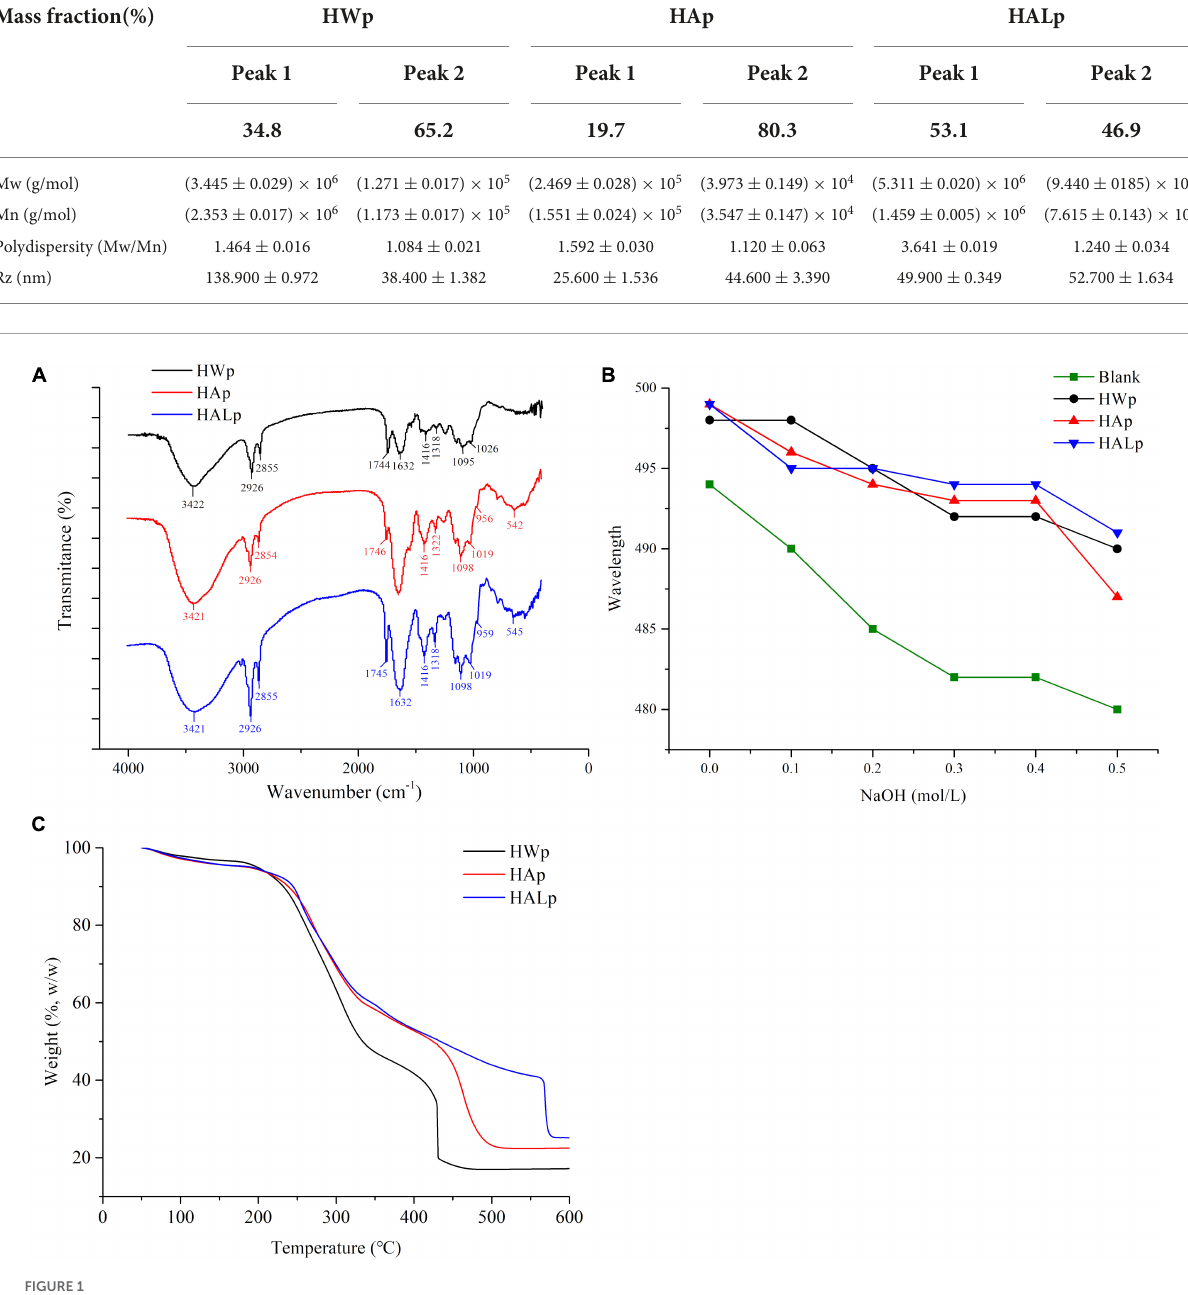
TABLE 2 The molecular parameters of HWp, HAp, and HALp.